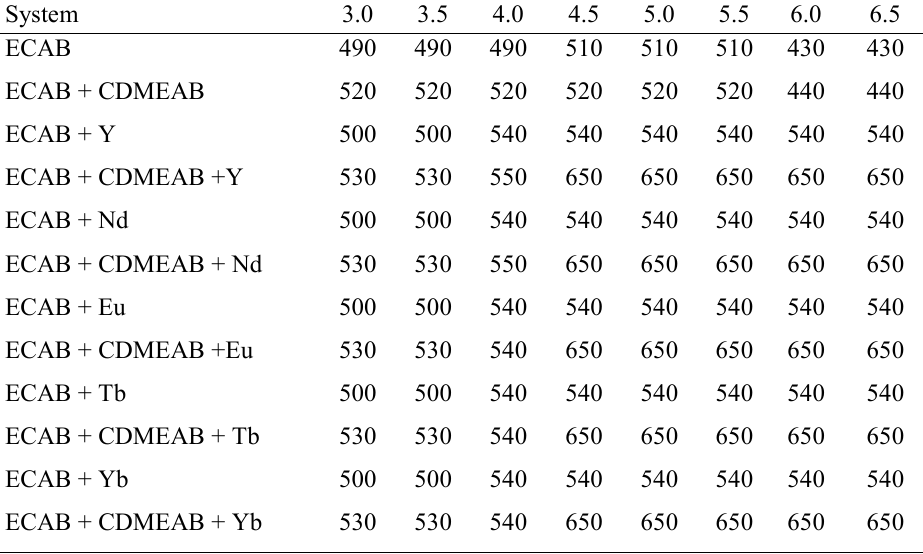
Figure 1. Effect of CDMEAB on ECAB in alkaline medium. Table 2. Absorbance maxima (nm) of ECAB and its complexes in absence and presence of CDMEAB at different